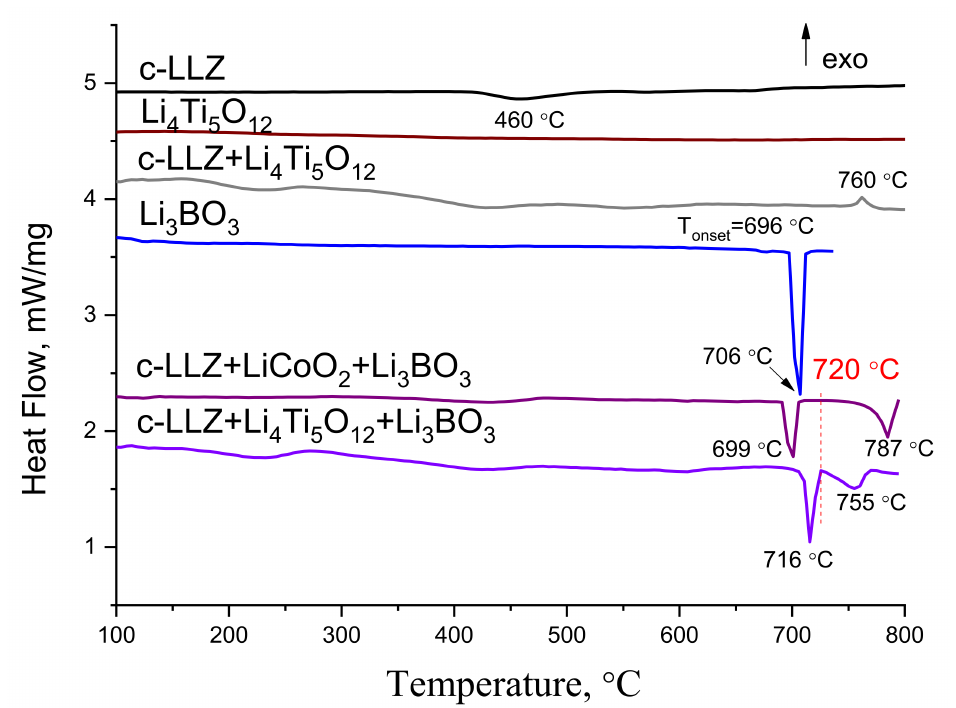
Figure 1. DSC curves of c-LLZ, Li 3 BO 3 , Li 4 Ti 5 O 12 and mixtures of c-LLZ + LCO + Li 3 BO 3 , c-LLZ + LTO, c-LLZ + LTO + Li 3 BO 3 powders.